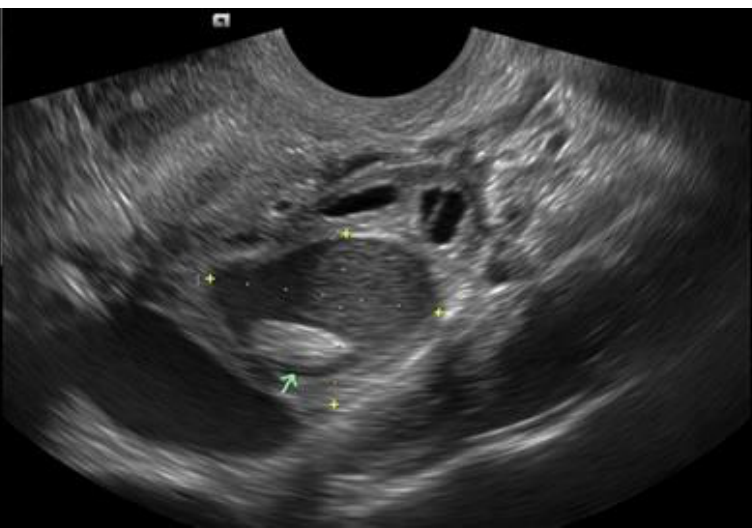
Figure 3. Atypical OMA with papillary projection (green arrow), likely representing a blood clot.